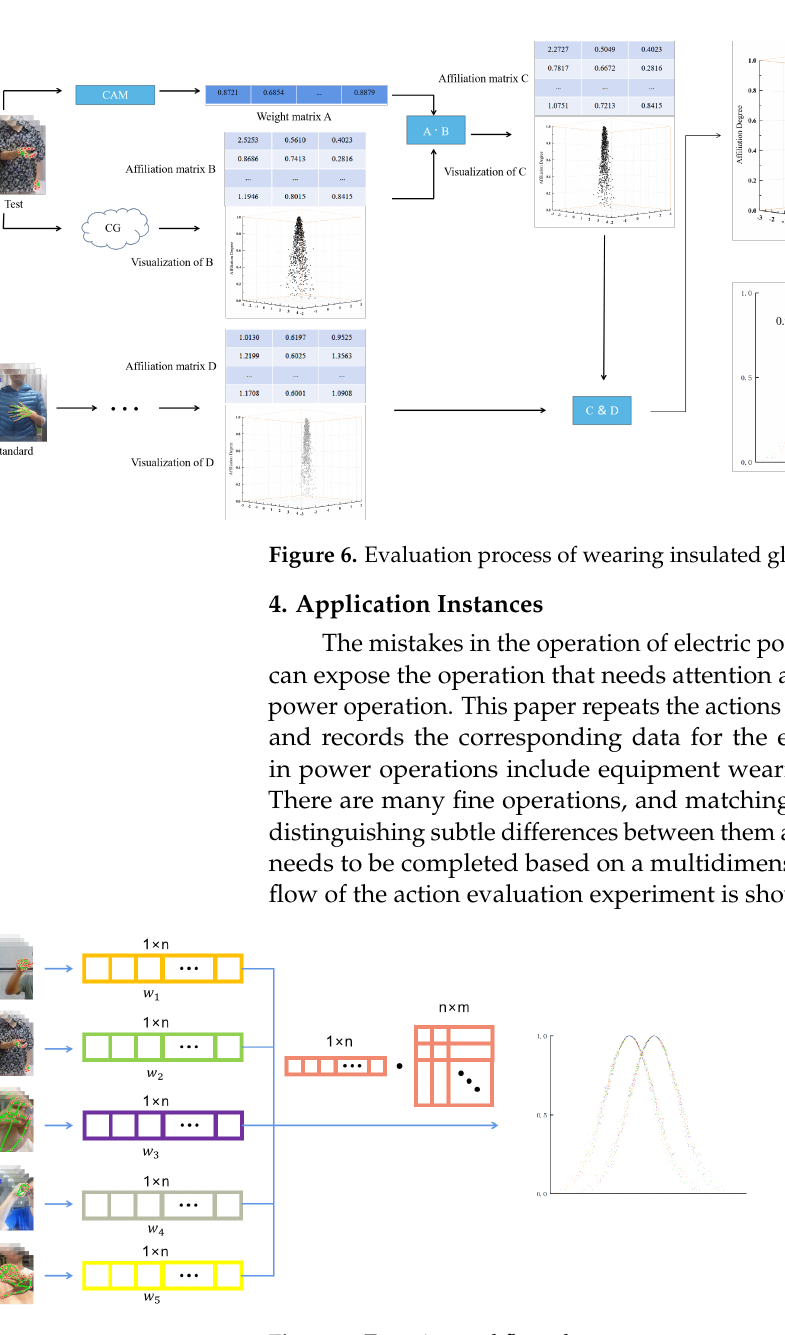
Figure 7. Experimental flow